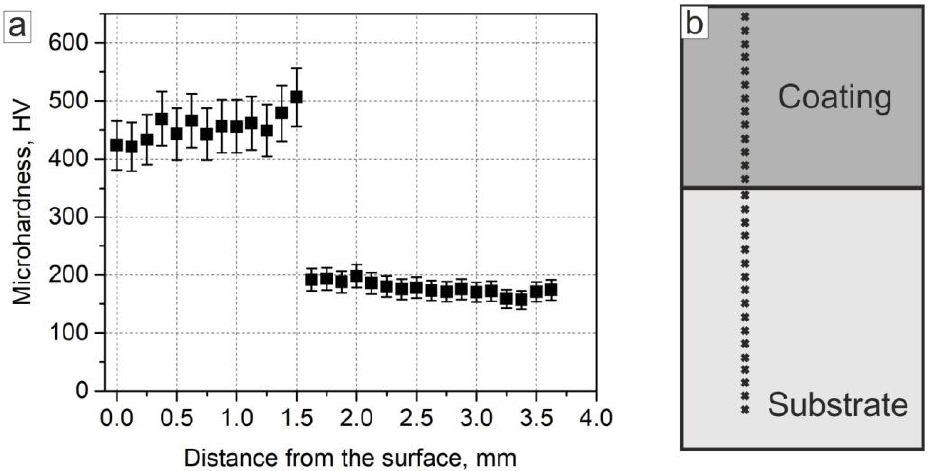
Figure 9. ( a ) Microhardness of NiAl-based coatings on low-carbon steel substrates in the cross-section; ( b ) Scheme of measurements.